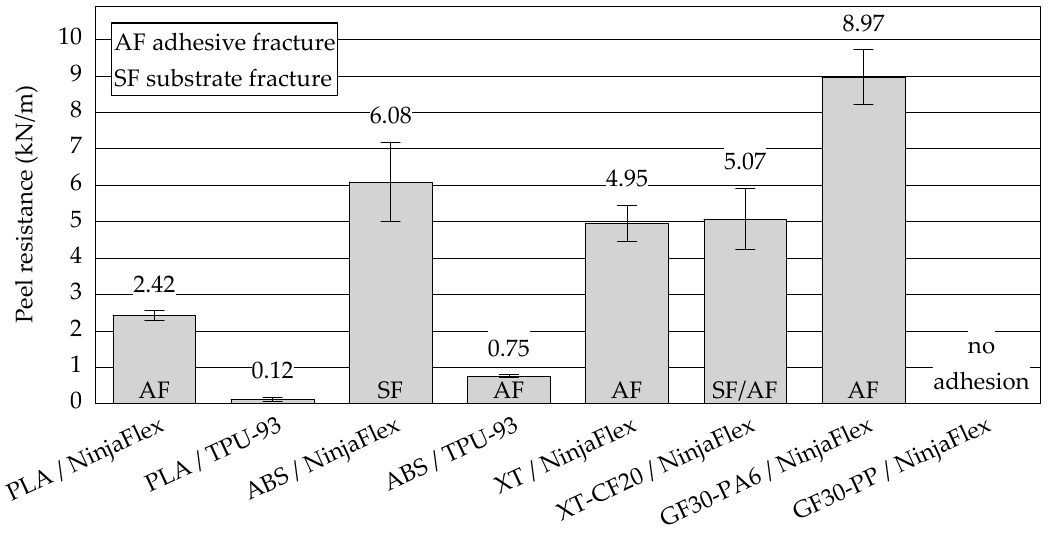
Figure 9. Overview of peel resistance of different material combinations.